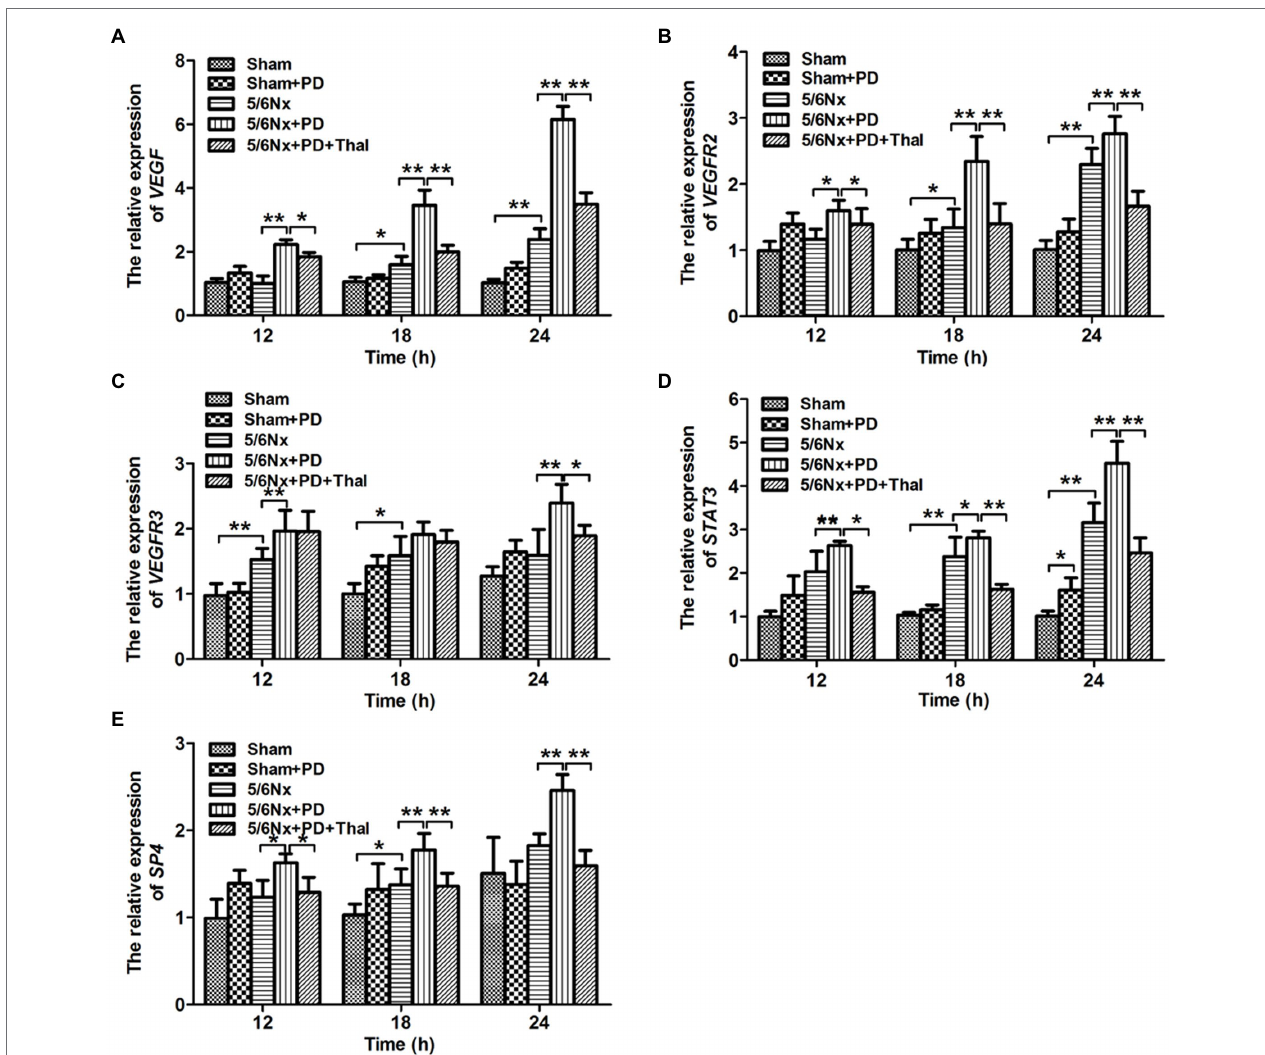
FIGURE 4 | Effect of thalidomide on peritoneal expression of endothelial-specific targets in 5/6Nx + PD model rats. qRT-PCR analyses were performed to evaluate the peritoneal expression of VEGF (A) , VEGFR2 (B) , VEGFR3 (C) , STAT3 (D) , and SP4 (E) in sham, sham+PD, 5/6Nx, 5/6Nx + PD, and 5/6Nx + PD rats intraperitoneally administered thalidomide at the indicated time points (12, 18, and 24 h). * p < 0.05; ** p <